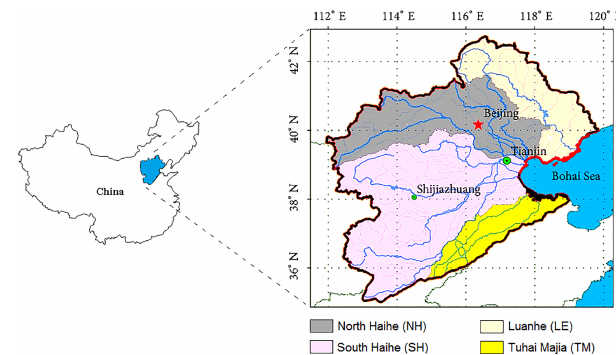
Figure 1. Location of Haihe River basin in the map of China. The sub-basins of the river and the location of major cities in the basin are also